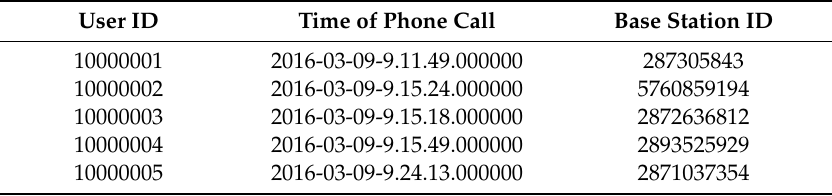
Table 1. Sample of mobile phone call